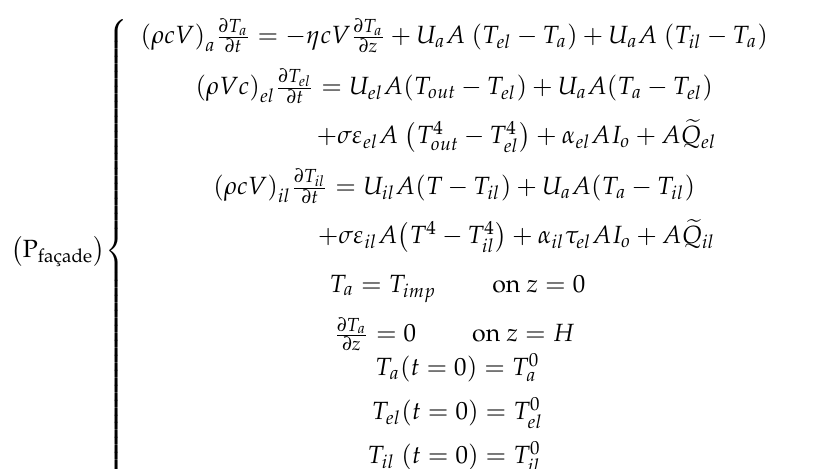
Figure 2. Sketch of the section of the façade.